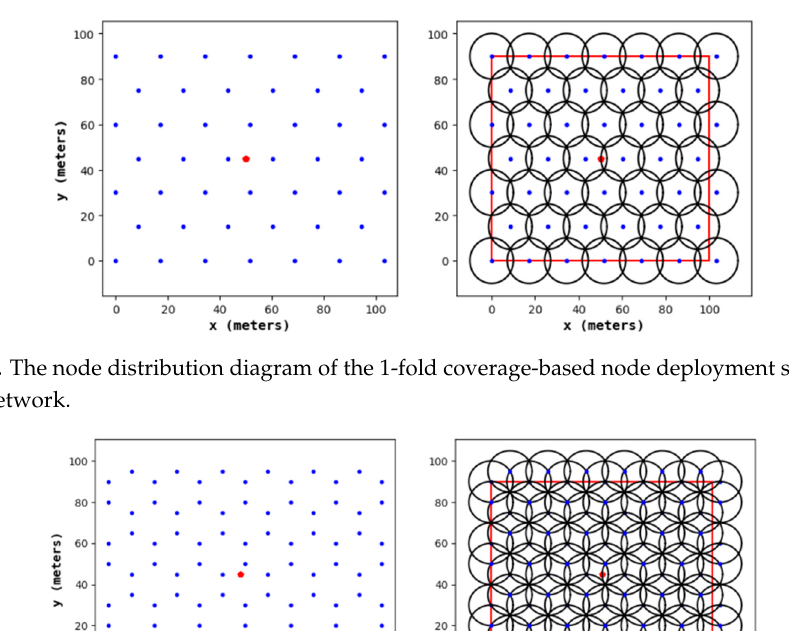
Figure 12. The node distribution diagram of the uniform node deployment strategy.